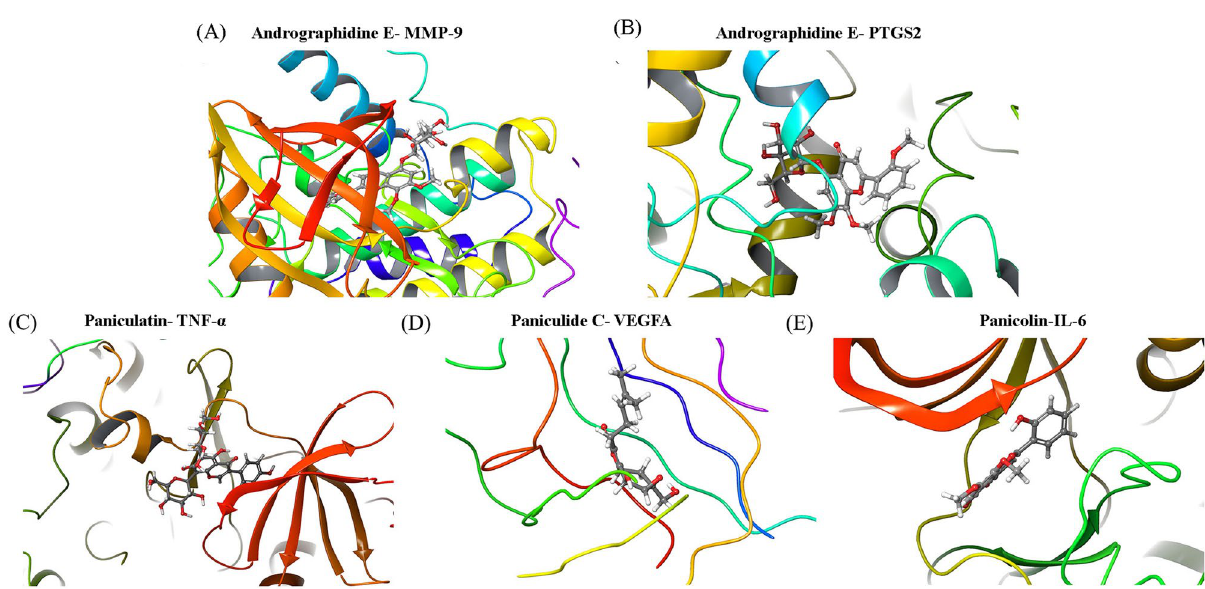
Figure 5. Molecular docking simulation for bioactive ingredients and the hub genes. ( A ) Andrographidine E-MMP-9 (score = − 9.01); ( B ) Andrographidine E-PTGS2 (score = − 7.41); ( C ) Paniculatin-TNF-α (score = − 8.964); ( D ) Paniculide C-VEGFA (score = − 7.357); and ( E ) Panicolin-IL-6 (score = -